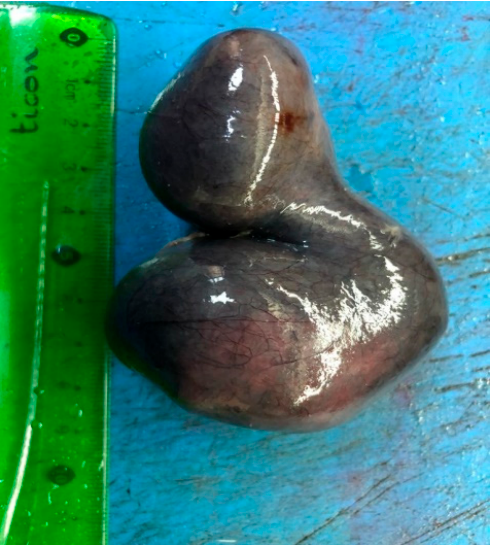
Figure 2. Isolated fallopian tube torsion material caused by hydrohematosalpinx.